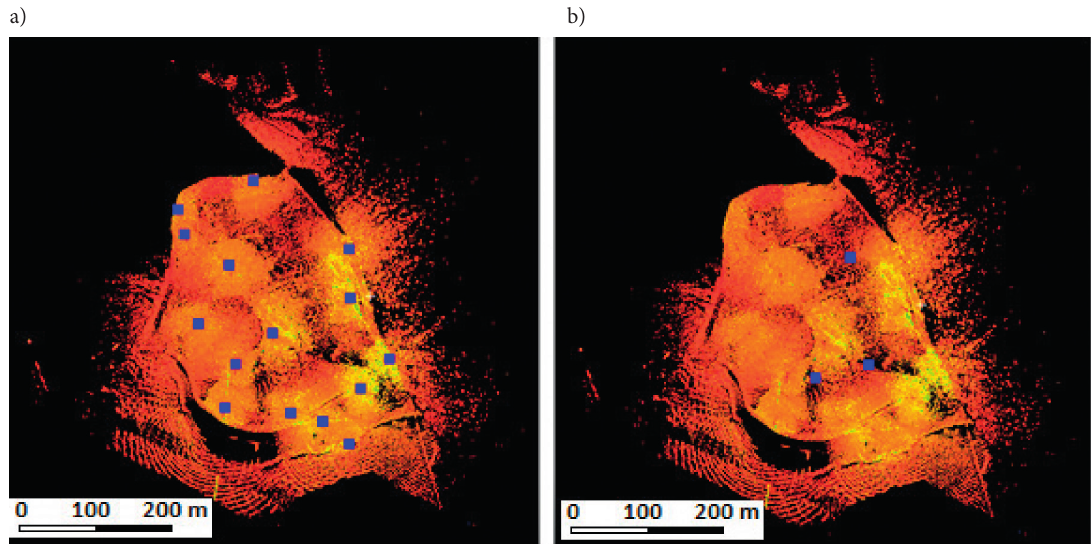
Fig. 4. The placement of scanning stations and HDS targets on the semi-coke landfill where a) TLS scanning stations; b) high definition scanning targets. Both are presented as blue squares placed on the TLS point cloud (visualised via the TLS signal